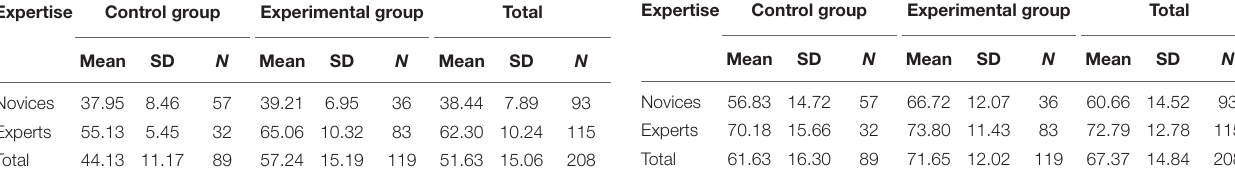
TABLE 1 | Descriptive statistics of pre-service teachers’ performance on the pre-test. Expertise